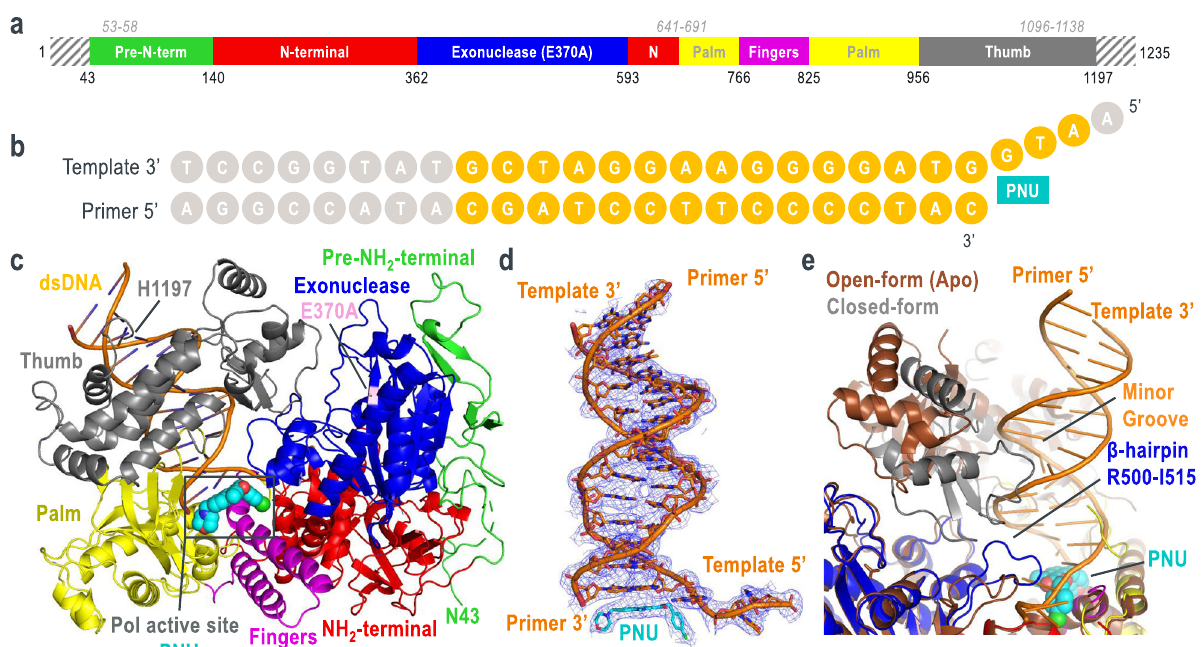
Fig. 2 Global structure of HSV1 pol ternary complex. a Domain organization of HSV1 pol construct used for crystallographic studies. Residues ranges not present in this construct are shown as boxes with gray hash marks. Disordered residue ranges are labeled in gray italics. b Primer-template DNA schematic. DNA nucleotides are shown as circles. Gray circles represent nucleotides that were not resolved in the crystal structure. c HSV1 pol ternary complex structure. Protein and primer/template DNA are represented as cartoons. PNU is represented as spheres at the polymerase active site. d 2F O -F C electron density (contoured at 1 σ ) for primer-template DNA and PNU. e Overlay of HSV1 pol apo and ternary complex structures highlighting thumb rotation to closed-form. The HSV1 pol apo structure is colored